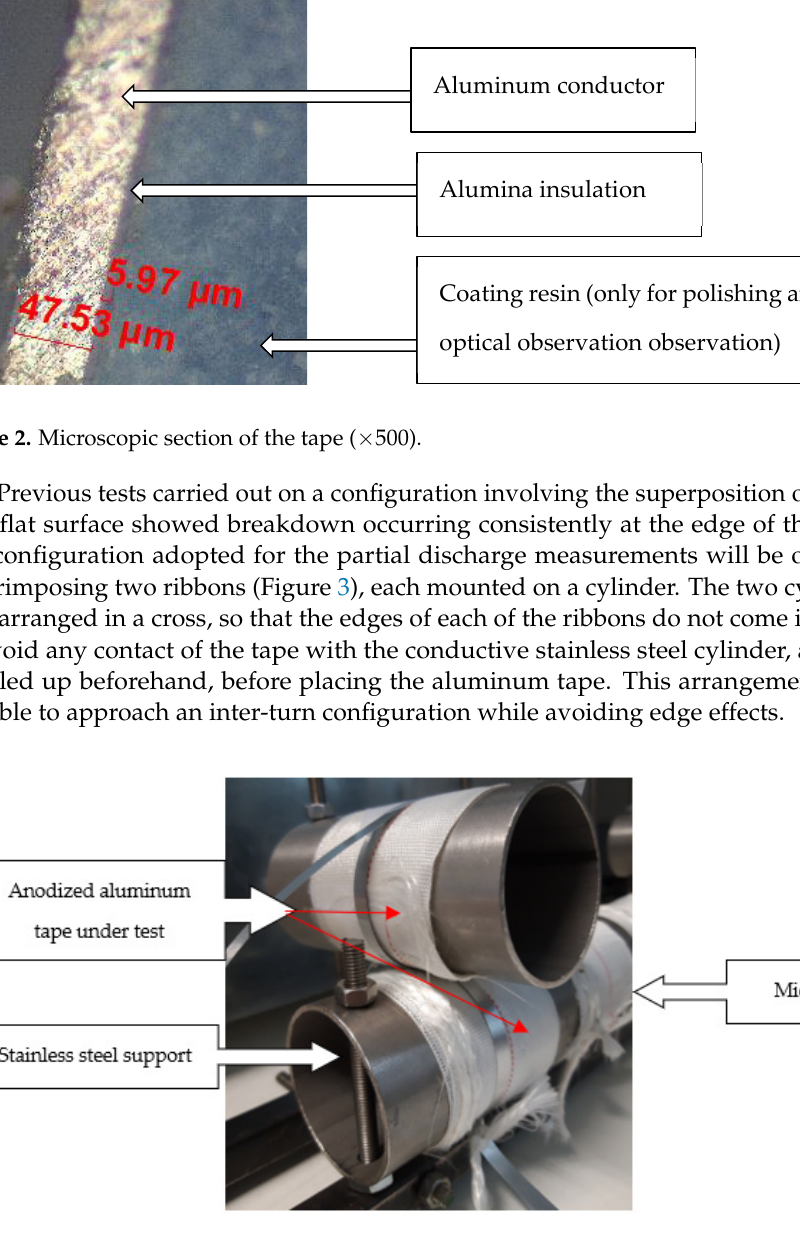
Figure 3. Crossed samples configuration.